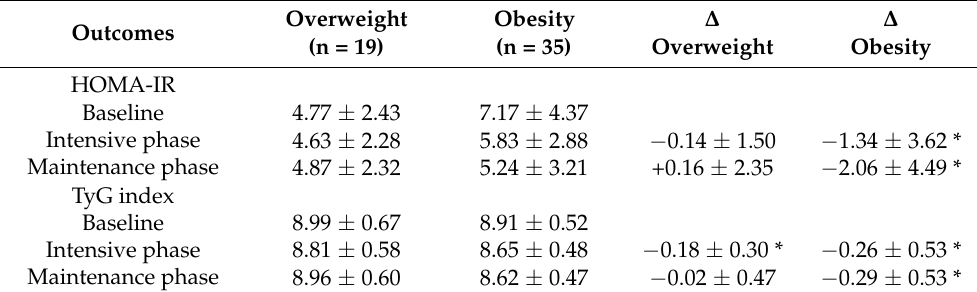
Table 4. Comparison of IR markers in the completer subjects with overweight or obesity.